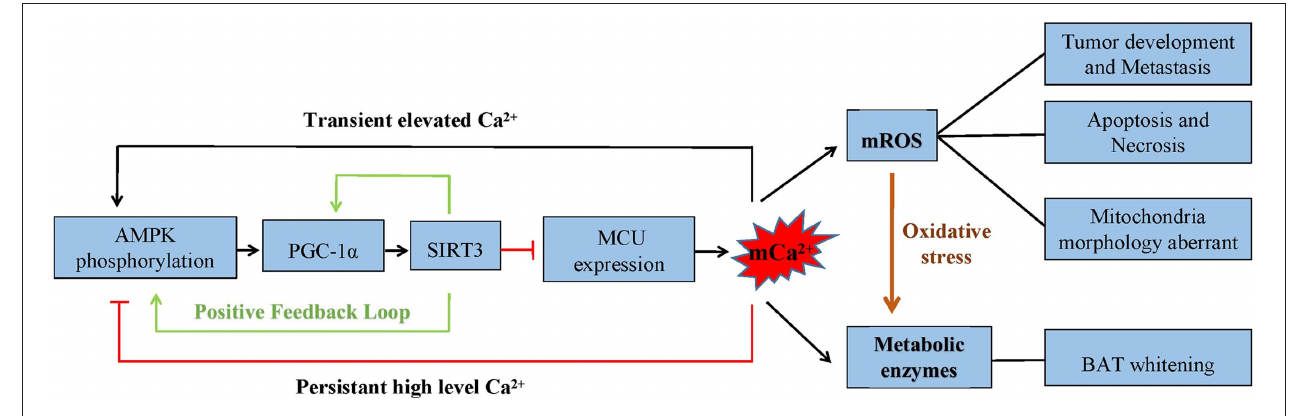
FIGURE 4 | The AMPK/PGC-1 α /SIRT3 signaling pathway inhibits the expression of MCU. The capability of mCa 2 + uptake is decreased, which inhibits mROS generation. Cell metabolism, apoptosis, and necrosis are significantly affected by mCa 2 + -dependent mROS production. Also, the crosstalk between AMPK/PGC-1 α and SIRT3 forms a positive feedback loop. The phosphorylation of AMPK is found to be different under a transient and persistent elevation of calcium.